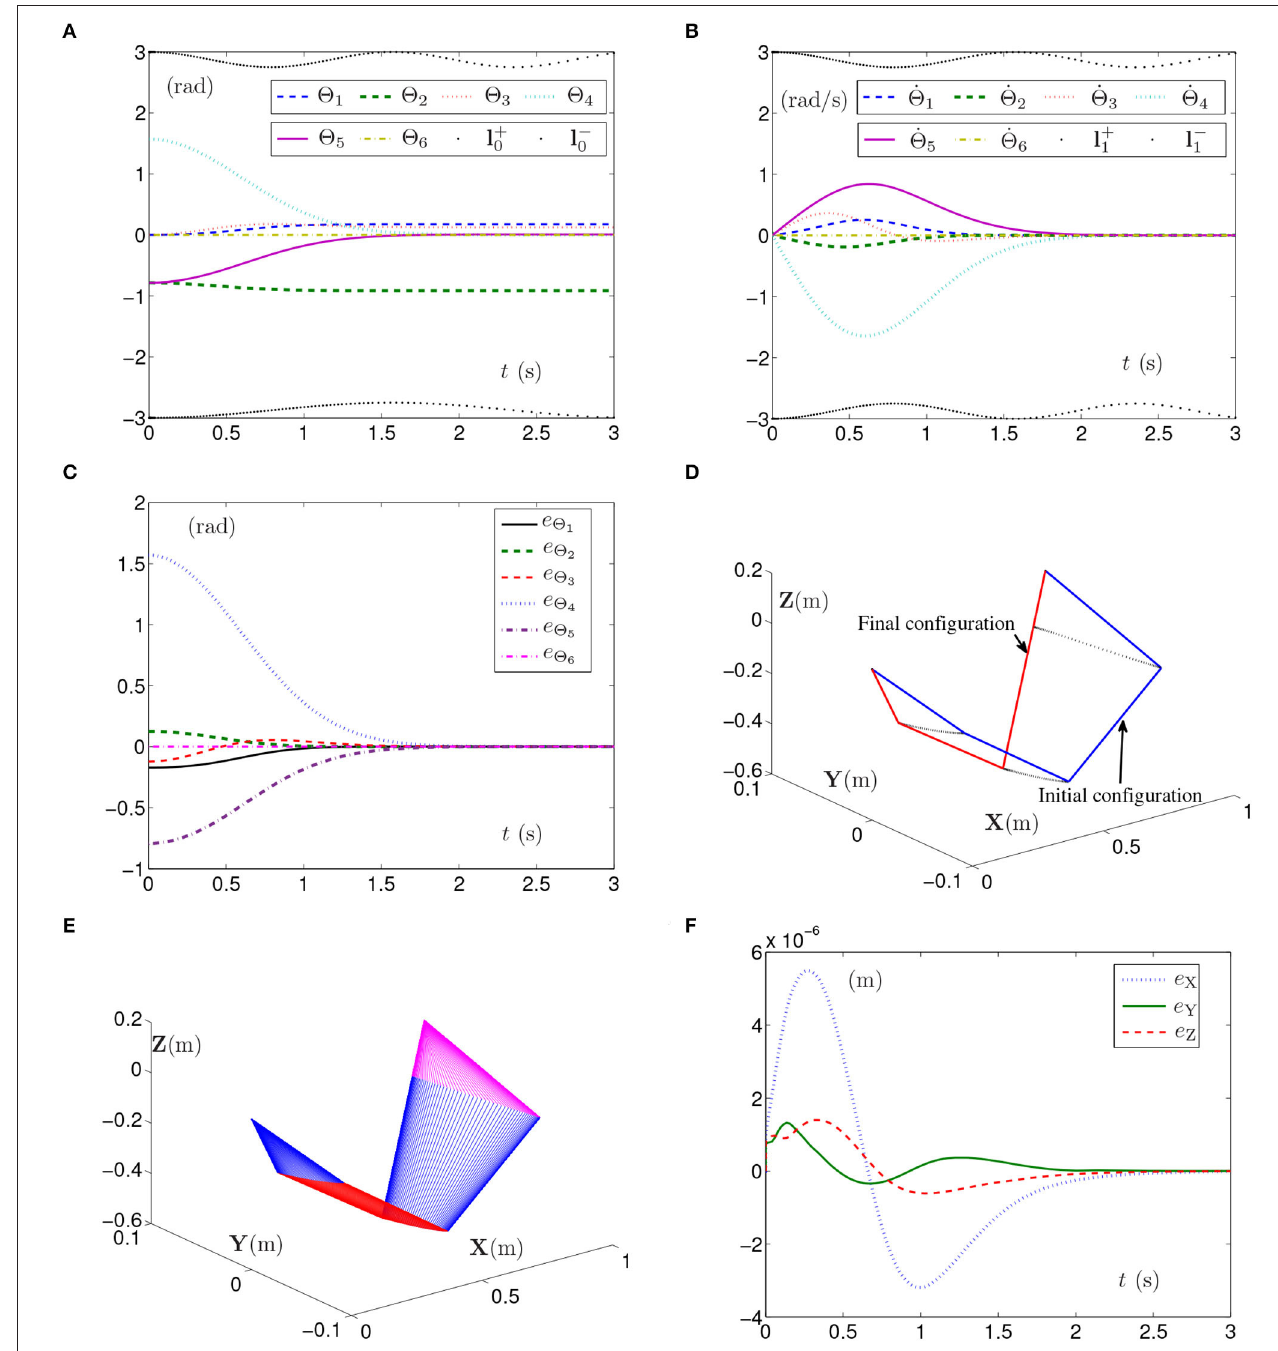
FIGURE 8 | Synthesized results of the PUMA560 manipulator using SMCSvZ with time-varying physical limits satisfied. (A) Profiles of joint angles. (B) Profiles of joint-angle velocities. (C) Profiles of joint-angle errors. (D) Profiles of initial and final manipulator positions. (E) Profiles of the planar manipulator. (F) Profiles of end-effector position